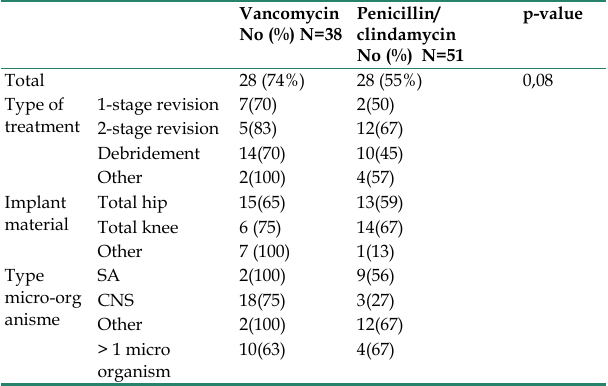
Table 2. Number of patients with successful treatment (no reinfection within 1 year)